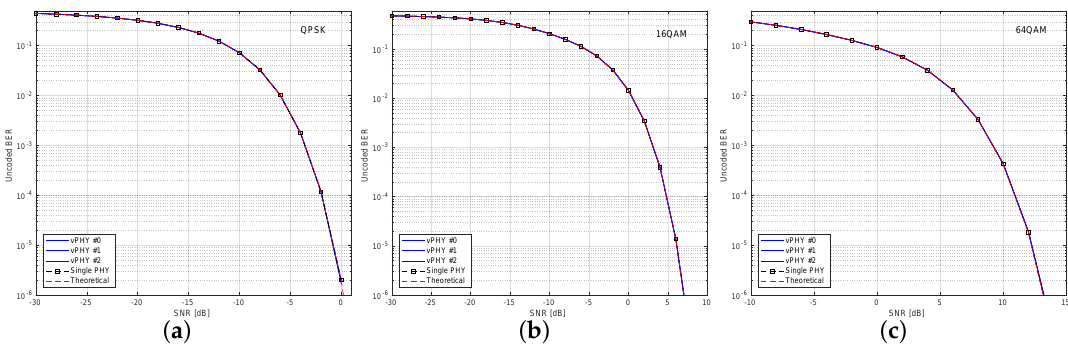
Figure 16. BER curves for a setup with 3 vPHYs with uncorrelated numerologies. Modulations used are ( a ) QPSK, ( b ) 16QAM and ( c ) 64QAM modulation